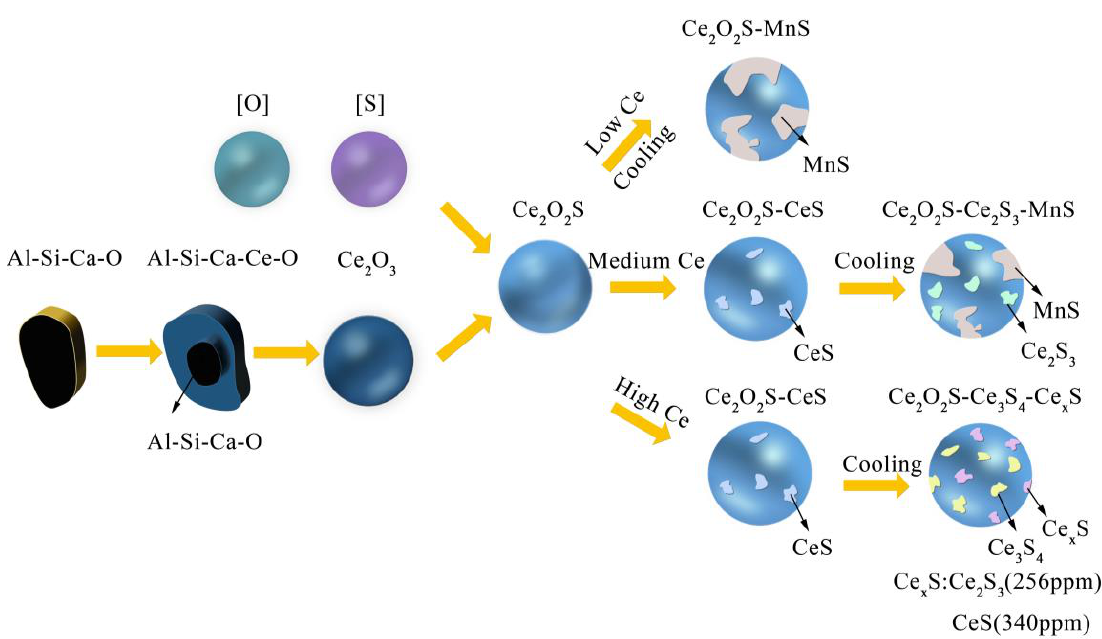
Figure 10. The evolution mechanism of main inclusions in the present study.